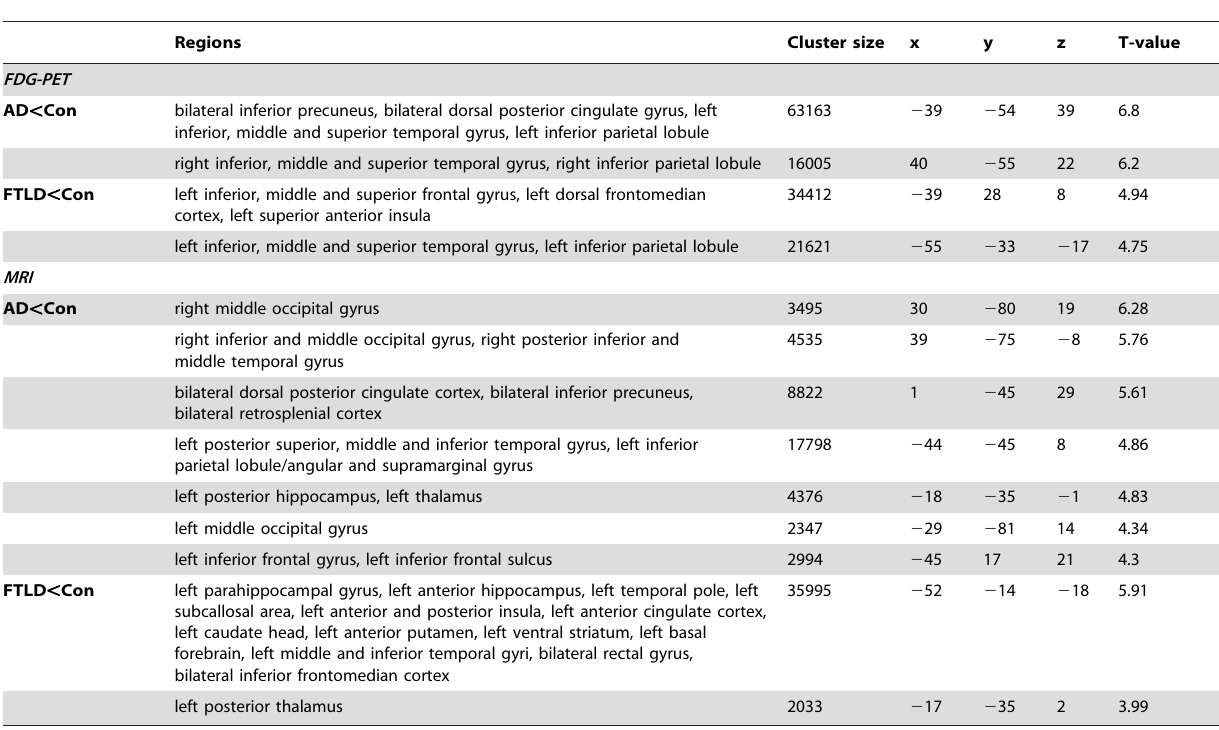
Table 2. Differences in hypometabolism and atrophy between groups.